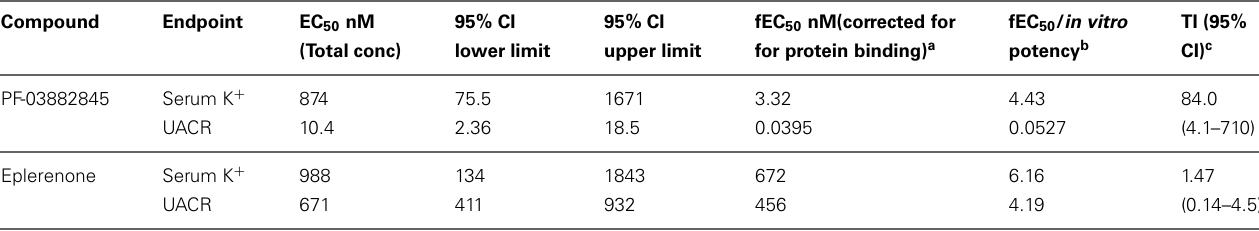
Data expressed as EC 50 with 95% confidence interval (CI). a fEC